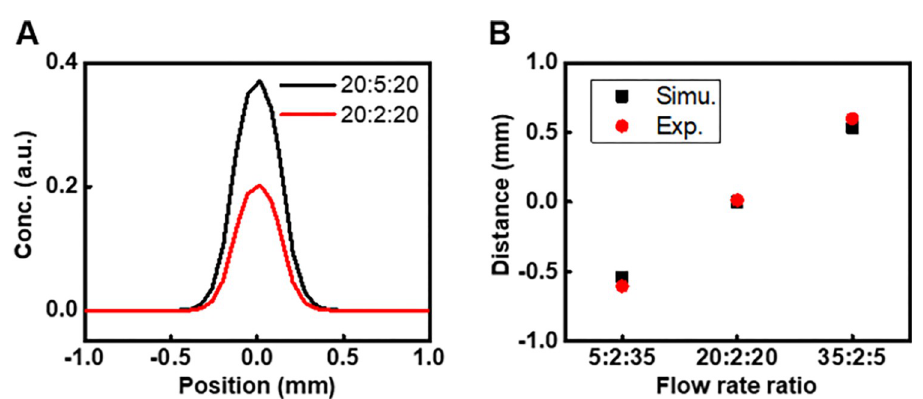
Fig 2. Quantitative profiles of hydrodynamic focusing and shifting in the HFSM. A Simulation profiles of differences in lateral concentration of sample fluid at the entrance to the culture chamber in the device for different sample flow rates. B Simulation predictions and experimental measurement of distance of the sample stream from the centerline of the culture chamber at different side flow rates.